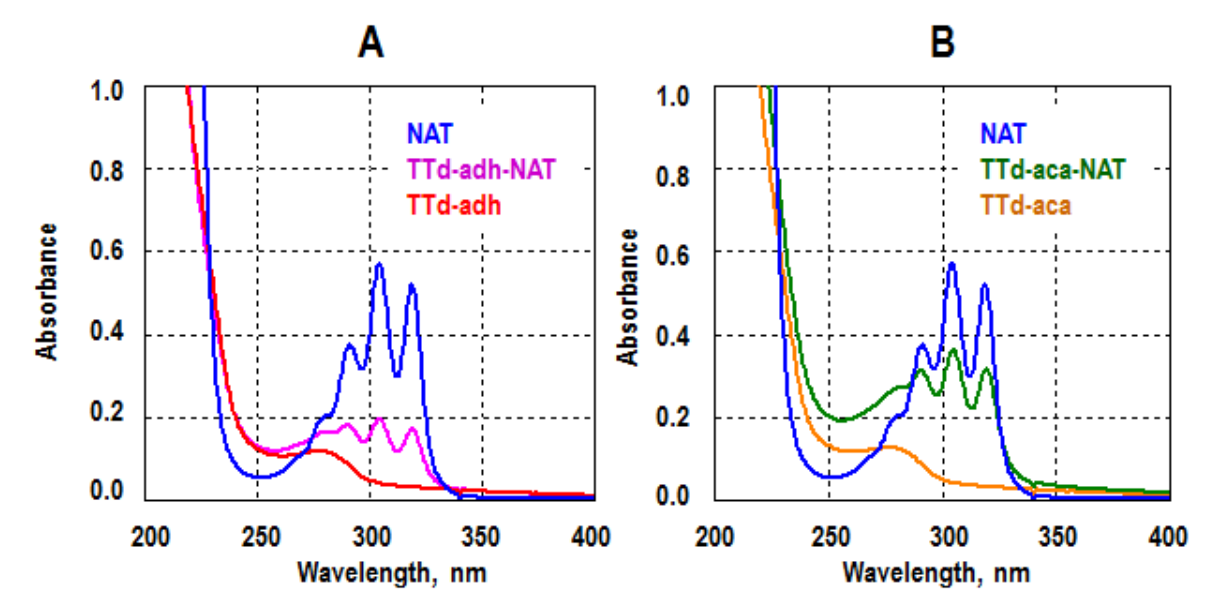
Figure 1. Structures of NAT-based immunogens and coating antigens for indirect competitive ELISA. NAT—blue; protein carrier—black; spacer—red.